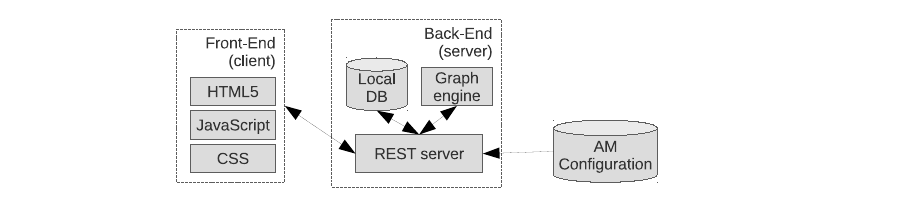
Figure 2. The architecture of the Policy